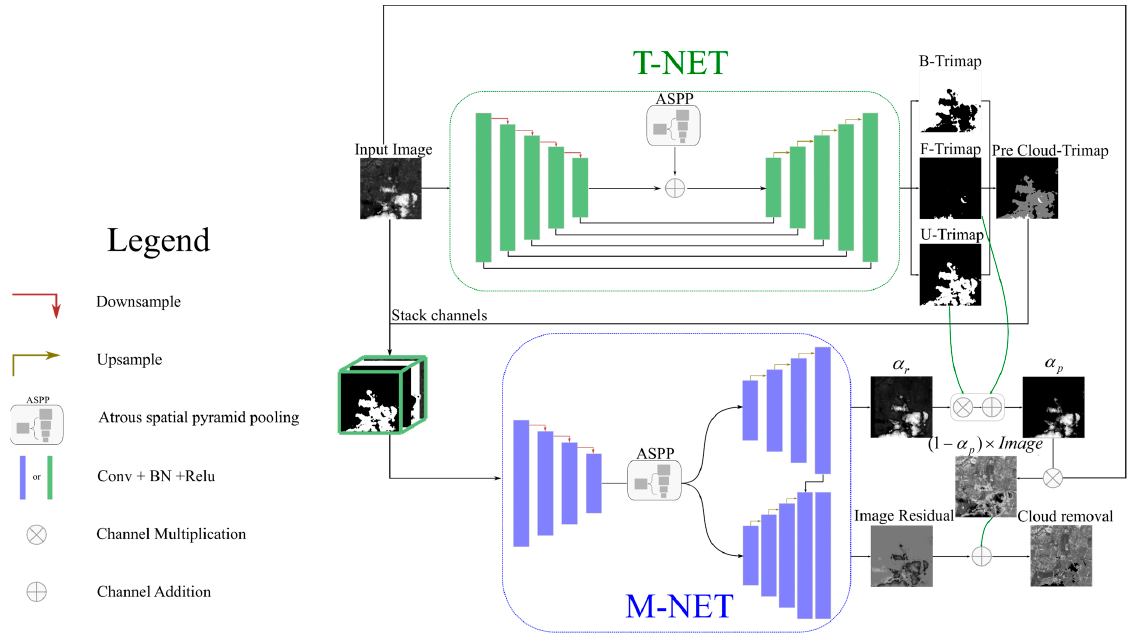
Figure 2. Two-step cloud-matting model.